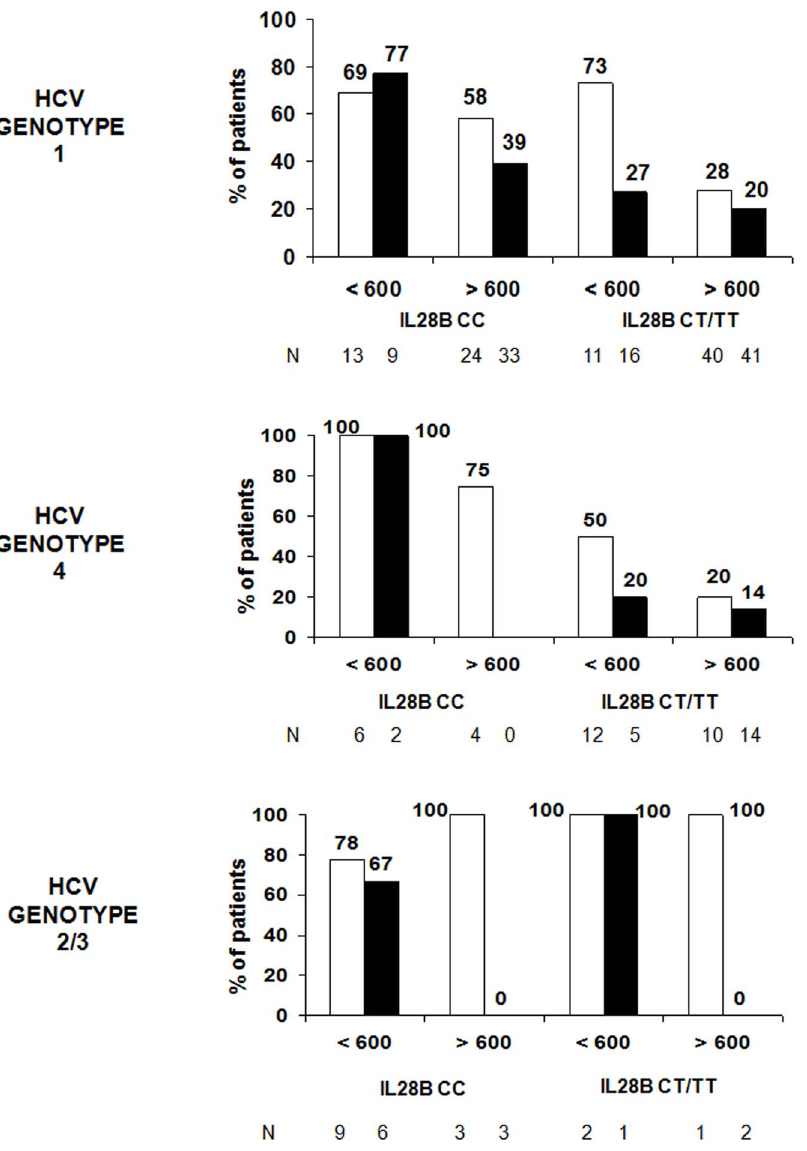
Figure 1. Percentages of HIV/HCV coinfected patients with sustained virological response to pegylated interferon- a 2a plus ribavirin as a function of IL28B polymorphism, HCV-RNA levels and presence (black) or absence (white) of significant liver fibrosis.